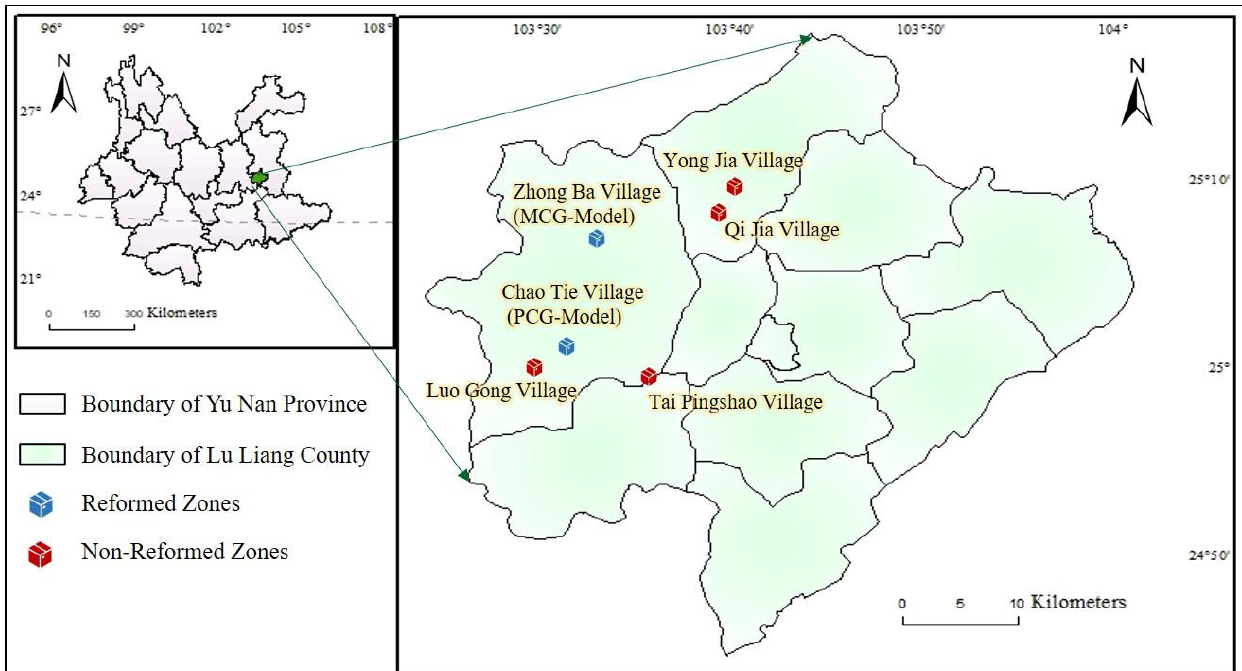
Figure 4. Microdata field study areas for this study. Note: In the picture, MCG-Model is the abbreviation for “ Multiple Cooperative Governance Model ” in the diagram; PCG-Model is the abbreviation for “ Private Contract Governance Model ” .